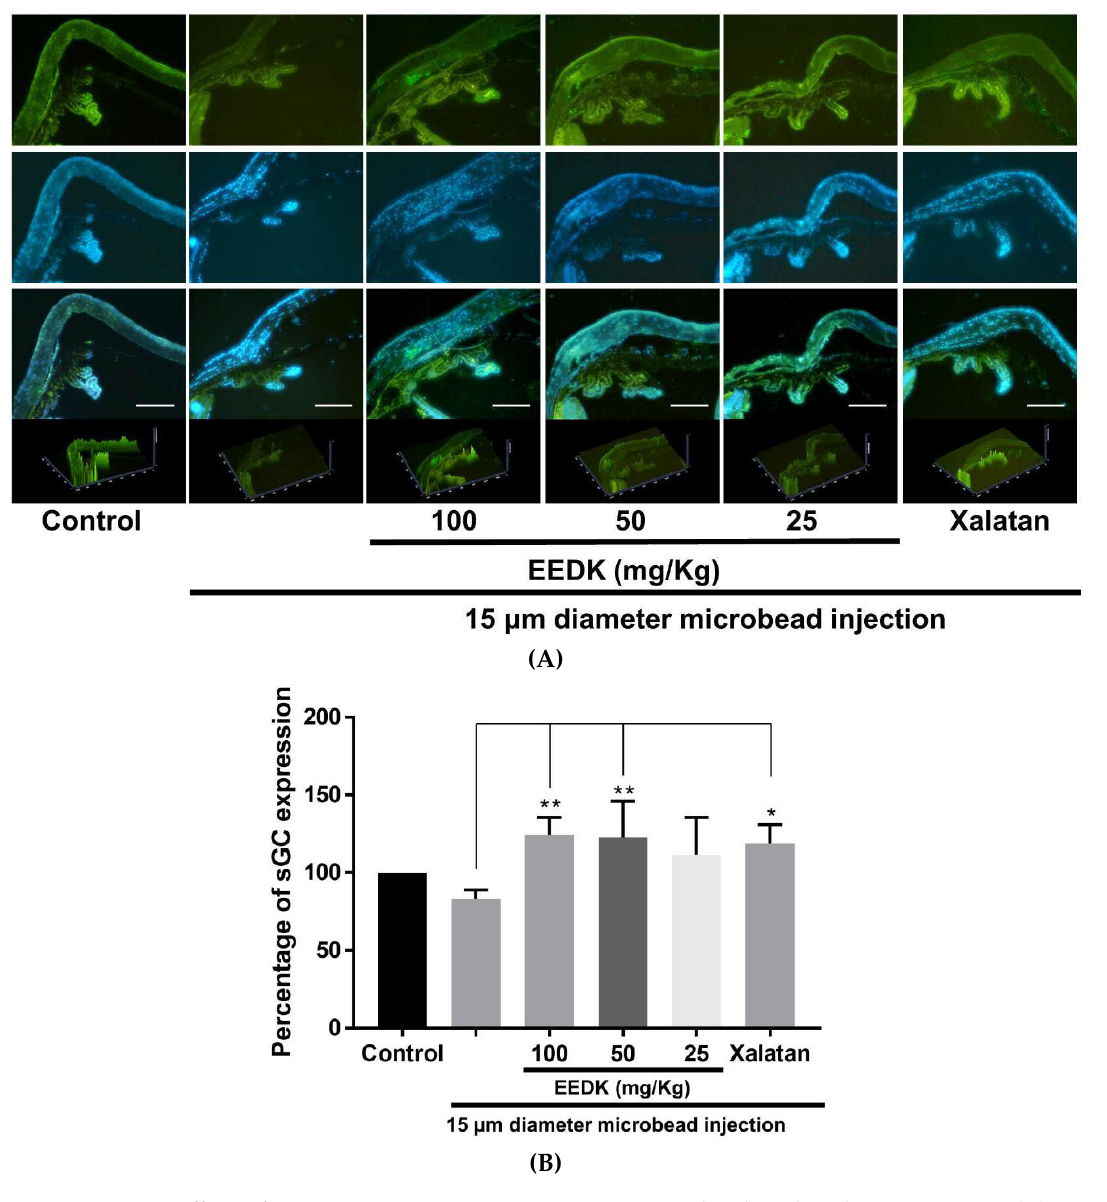
Figure 3B. In EEDK-administered groups (50 mg / kg and 100 mg / kg doses), the expression levels of sGC α -1 were significantly higher compared to the control, but similar to those obtained with Xalatan. These results suggested that EEDK could preserve the endogenous sGC α -1 expression in the anterior segment of OHT mouse model.